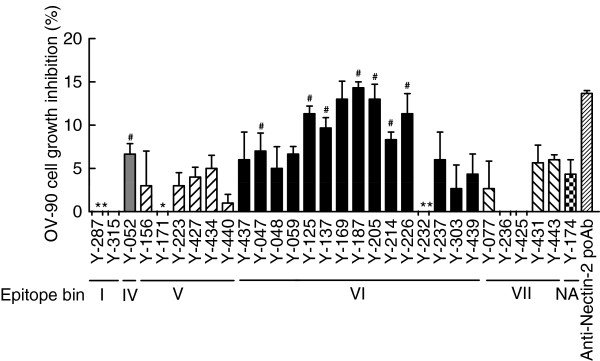
Inhibitory activity of anti-Nectin-2 mAbs on the proliferation of OV-90 cells. OV-90 cells were cultured in the presence of 30 μg/mL anti-Nectin-2 mAbs and poAb with 1% FBS for 6 days. The percentage inhibition of cell proliferation on the vertical axis is the mean ± S.D. of triplicate assays. *; antibodies that showed negative values for cell growth inhibition. #; antibodies that showed reproducible cell growth inhibition. NA; not assigned.